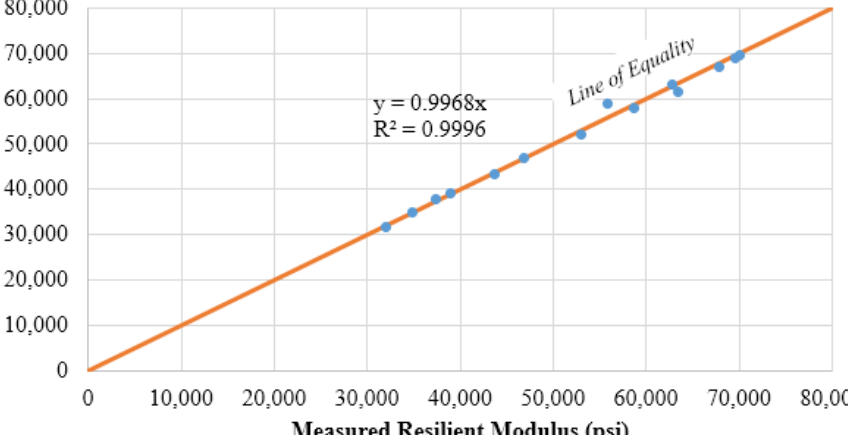
Figure 9. Universal model for RAP1 stockpile material.